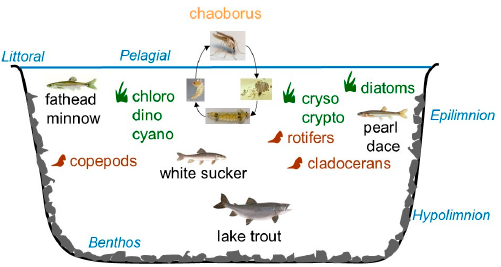
Figure 1. Conceptual model of the simplified food web used for the model (abbreviations: chloro = chlorophytes; dino = dinoflagellates; cyano = cyanophytes; cryso = chrysophytes and crypto=cryptophytes). Extension of Figure 1 in Clouzot and Vanrolleghem [12].